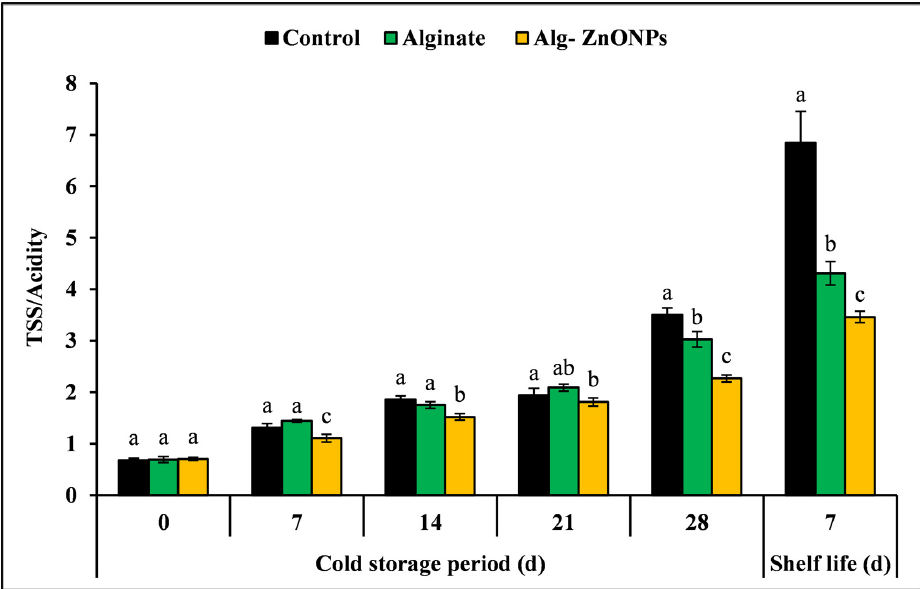
Figure 12. Effect of Alg–ZnO NPs on TSS/TA ratio of “Kiett” mango fruits during cold storage and shelf life; vertical bars represent the standard error (SE). Bars marked with the same letter in each sampling date are not significantly different with 95% confidence according to Duncan’s multiple range test.